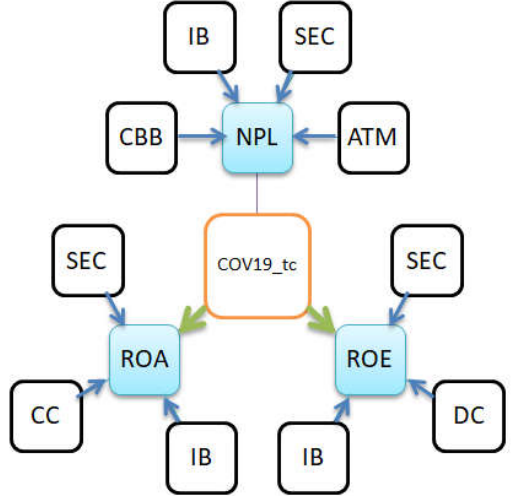
Figure 9. Pairwise Dumitrescu–Hurlin panel causality test.